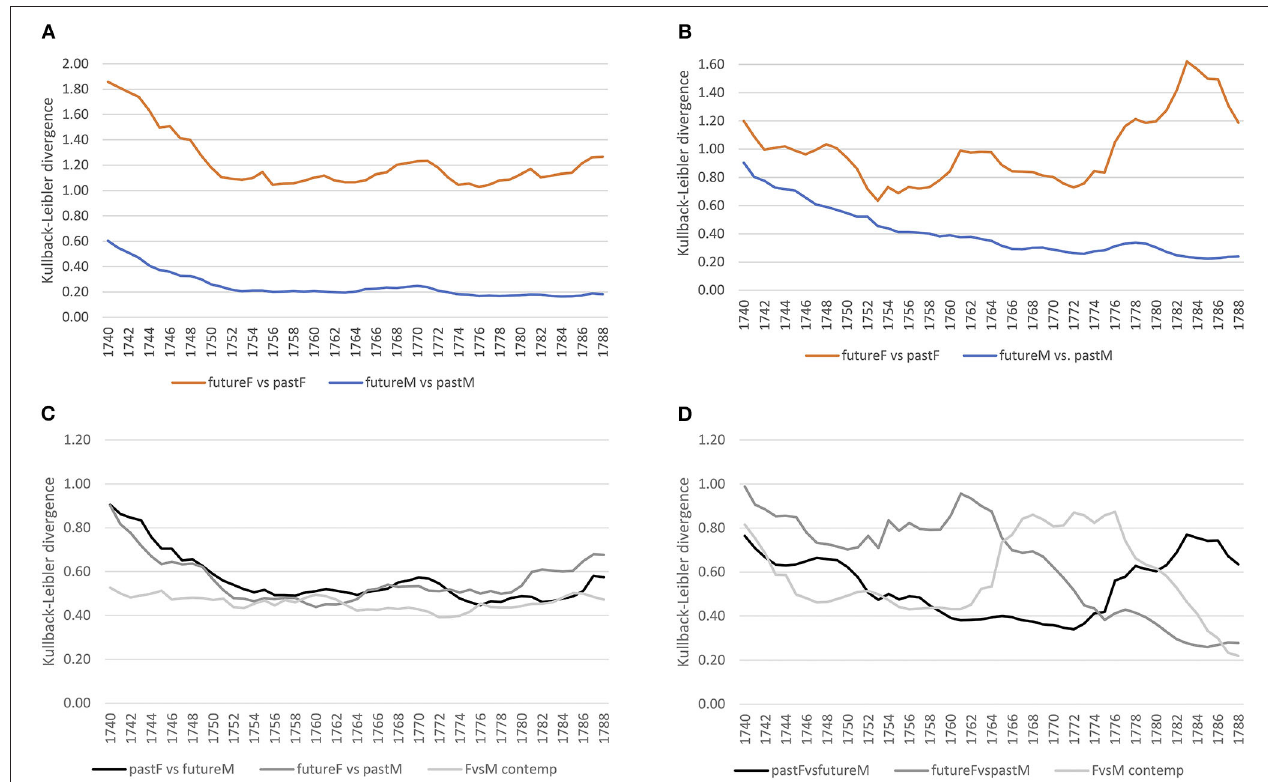
FIGURE 8 | Gender distinguished, diachronic and contemporary models (court vs. letter) at the grammatical level (pos-trigrams). (A) Court: within gender comparison. (B) Letter: within gender comparison. (C) Court: diachronic and contemporary comparison. (D) Letter: diachronic and contemporary comparison.